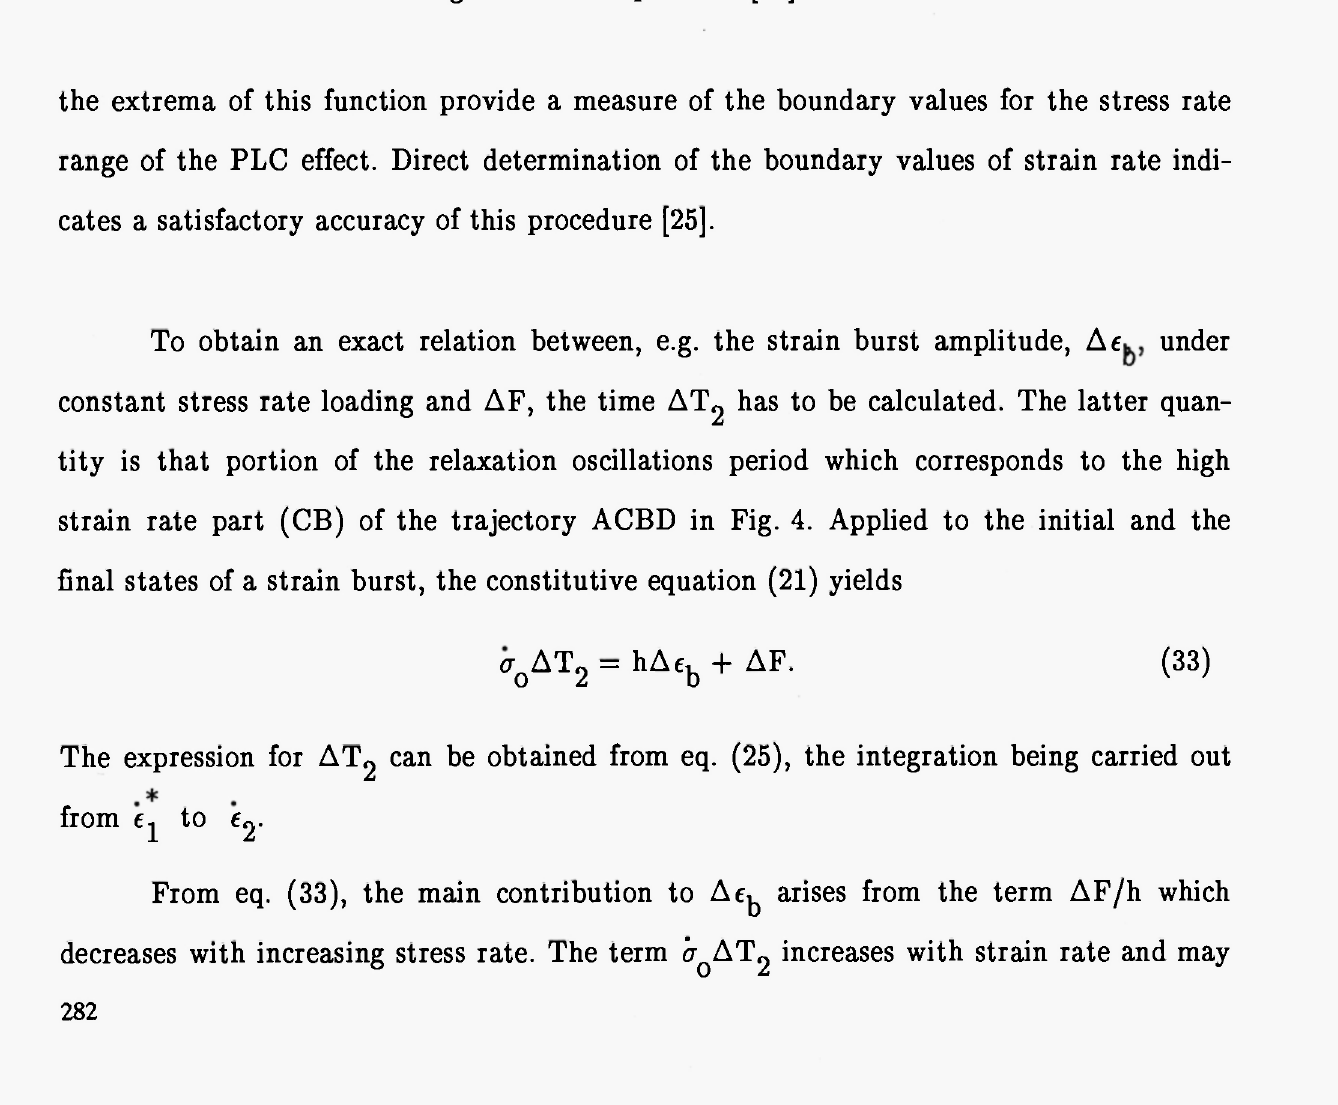
Fig. 13. Upper stress of PLC serrations at e = 8% as a function of imposed strain rate in Al-5%Mg at room temperature